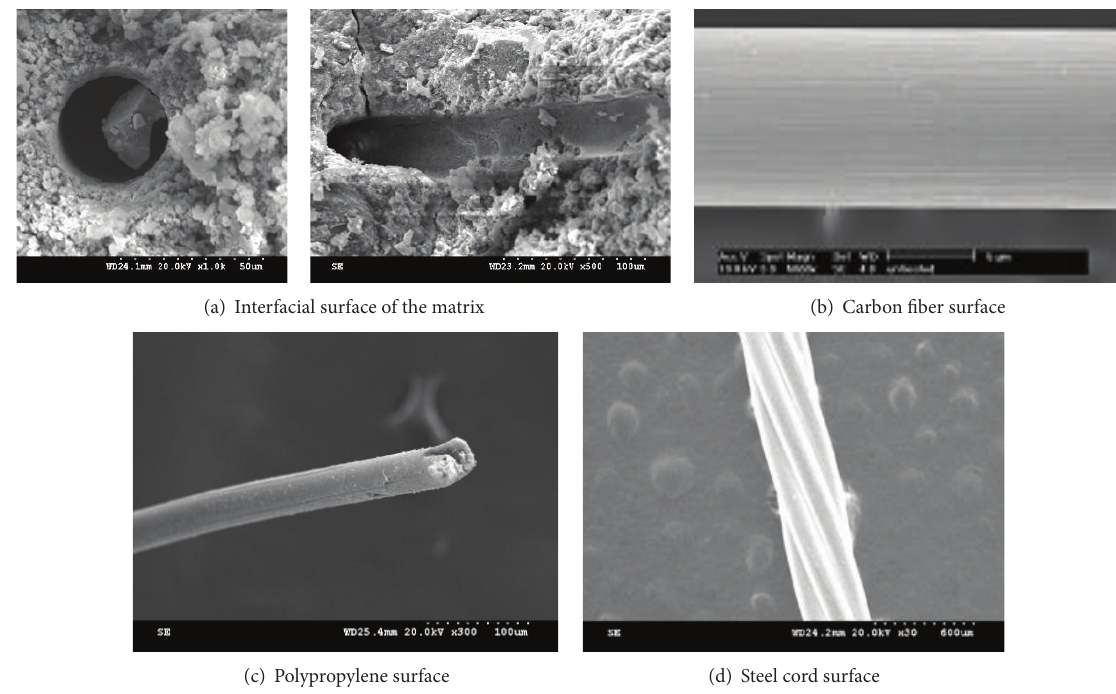
Figure 4: Interfacial surfaces of the cement composite matrix and fiber